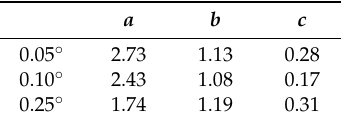
Figure 9. Error variances for the hourly gauge-based precipitation analysis under the different ( a ) gauge “truth” precipitation and ( b ) gauge network density at the 0.05° (blue line), 0.10° (red line) and 0.25° (green line) resolution. In this figure, N eg means the number of equivalent gauges. Table 3. Fitting coefficients, a , b and c , at grid resolutions of 0.05°, 0.10° and 0.25°, respectively.